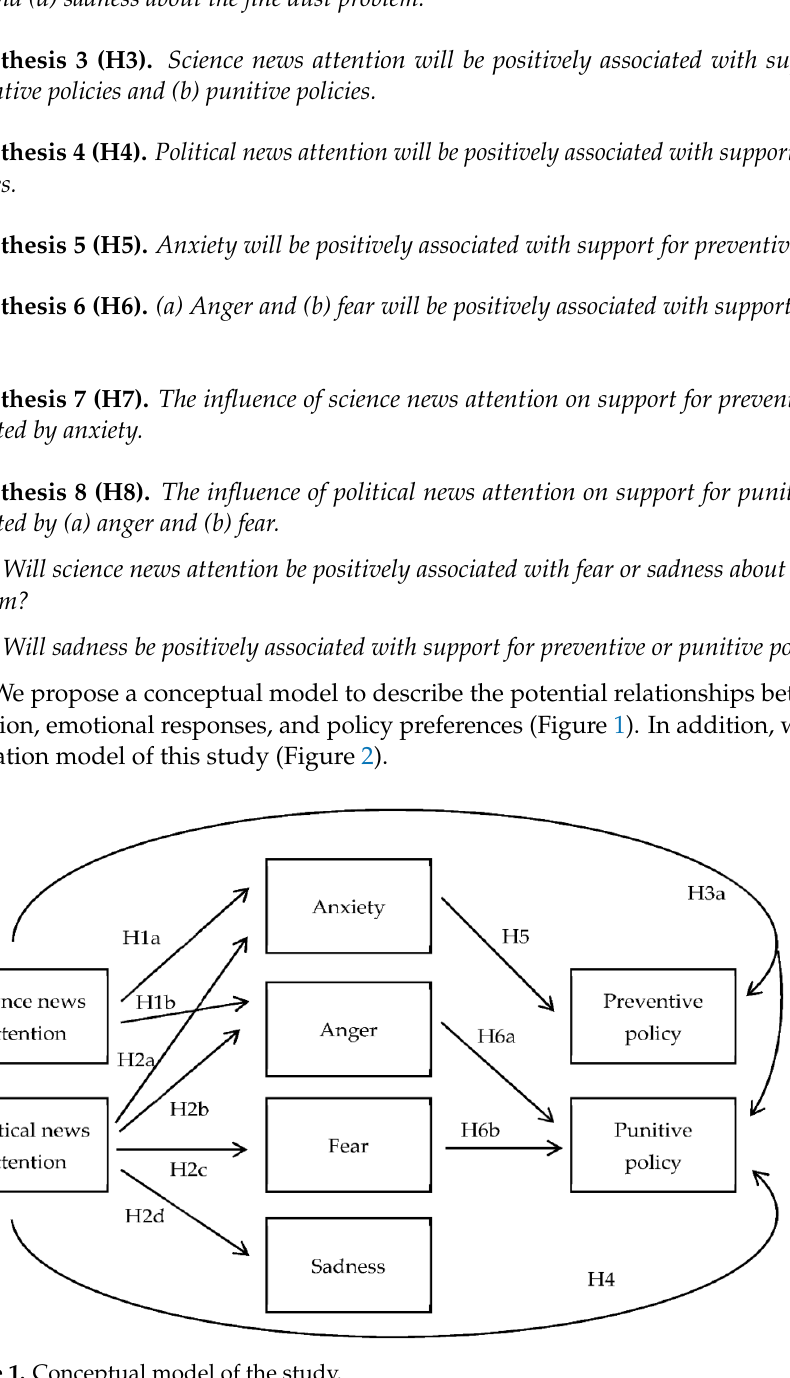
Figure 1. Conceptual model of the study.